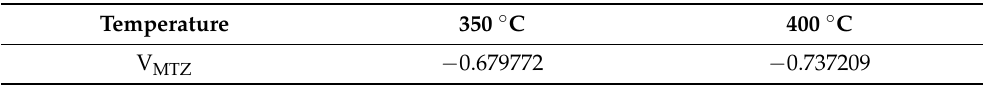
Table 4. The muffin-tin potential constant.